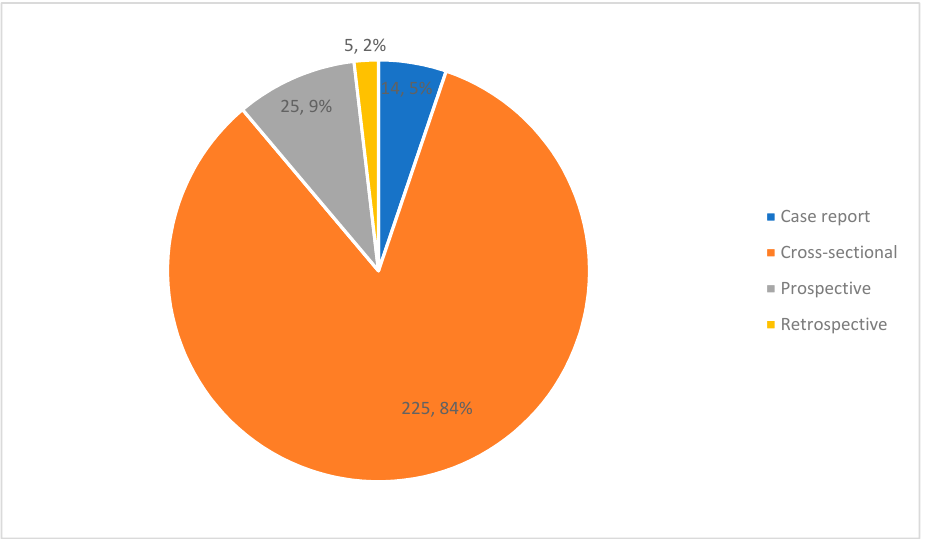
Figure 3. Types of observational studies (count, percent).